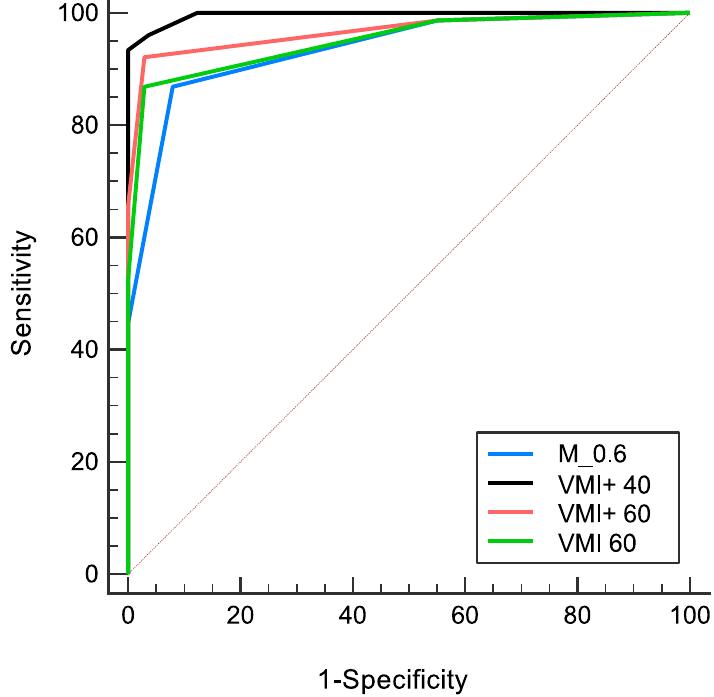
Figure 5. Results of the diagnostic performance analysis. The receiver operating characteristic (ROC) curves, derived from the ratings of the two readers for the detection of portal vein thrombosis, were highest for 40 keV noise-optimized virtual monoenergetic imaging (VMI+) series (AUC, 0.99) compared to 60 keV VMI+ (AUC, 0.97), 60 keV VMI (AUC, 0.95), and M_0.6 image reconstructions (AUC, 0.94) ( p <